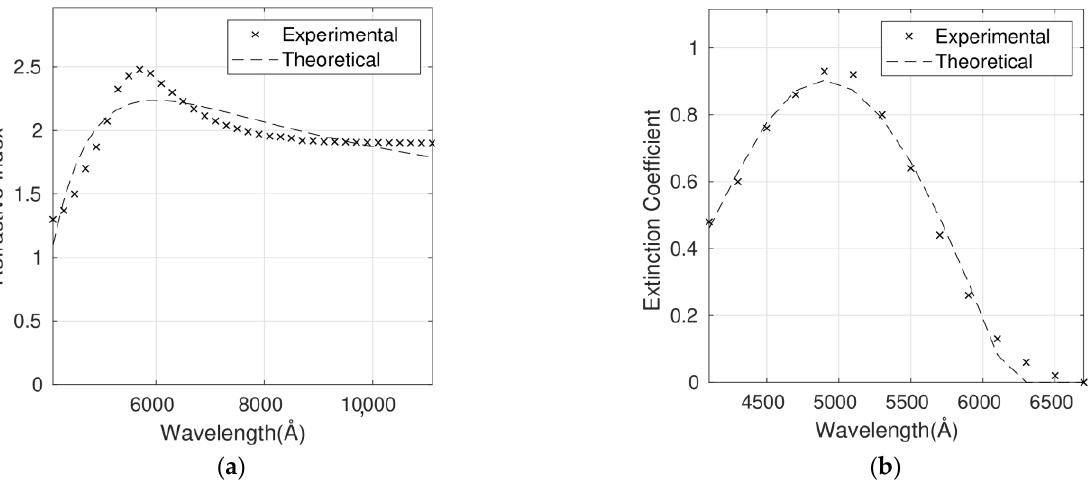
Figure 6. Refractive index ( a ) and extinction coefficient ( b ) fits to Cauchy´s equation for the P3HT/G (0.5 wt%) nanocomposite. Experimental data are adapted from Ref. [9] with permission from the American Institute of Physics, 2012.